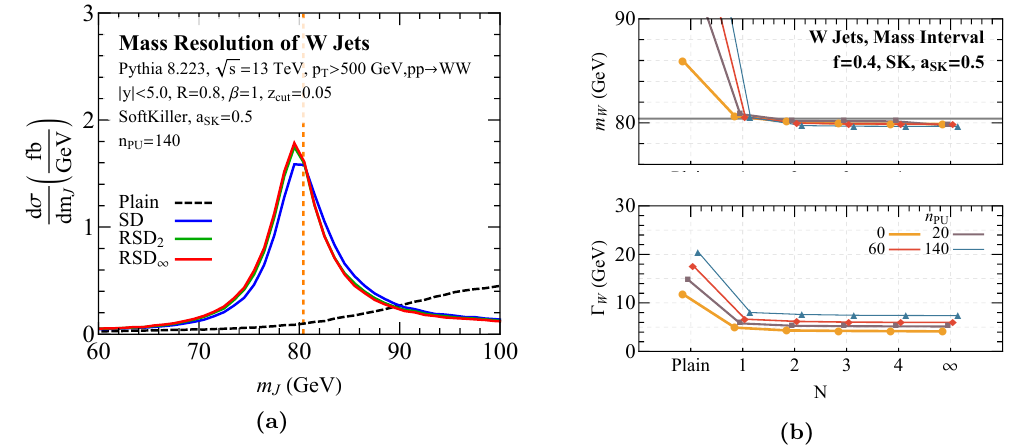
Figure 15. Same as (cid:12)gure 11 but for the W boson